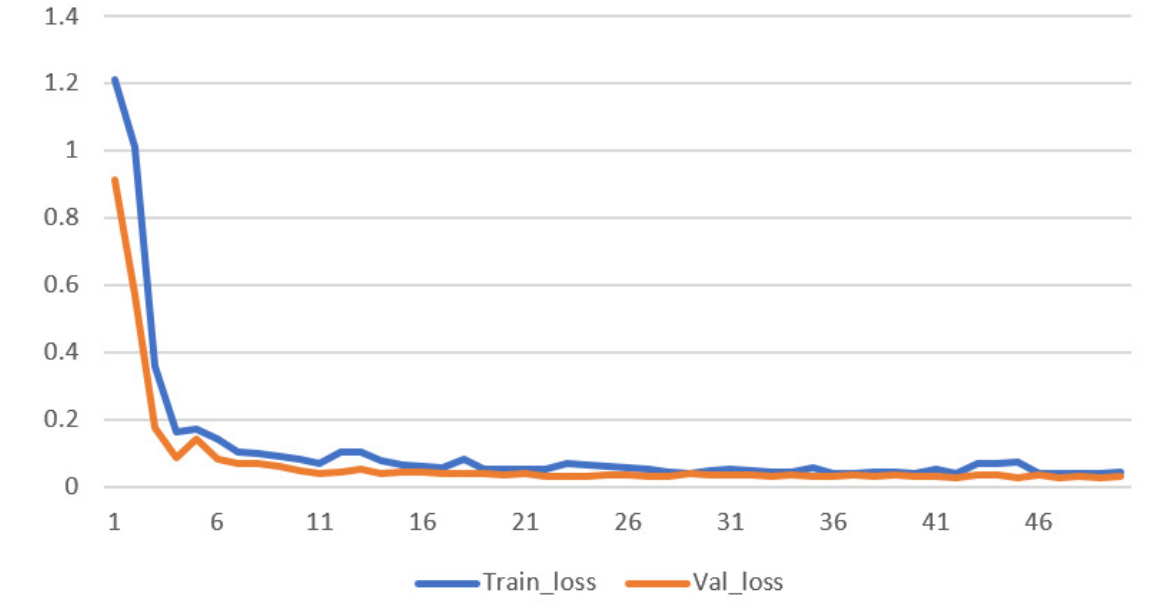
Table 10. Comparison with Existing Approaches.